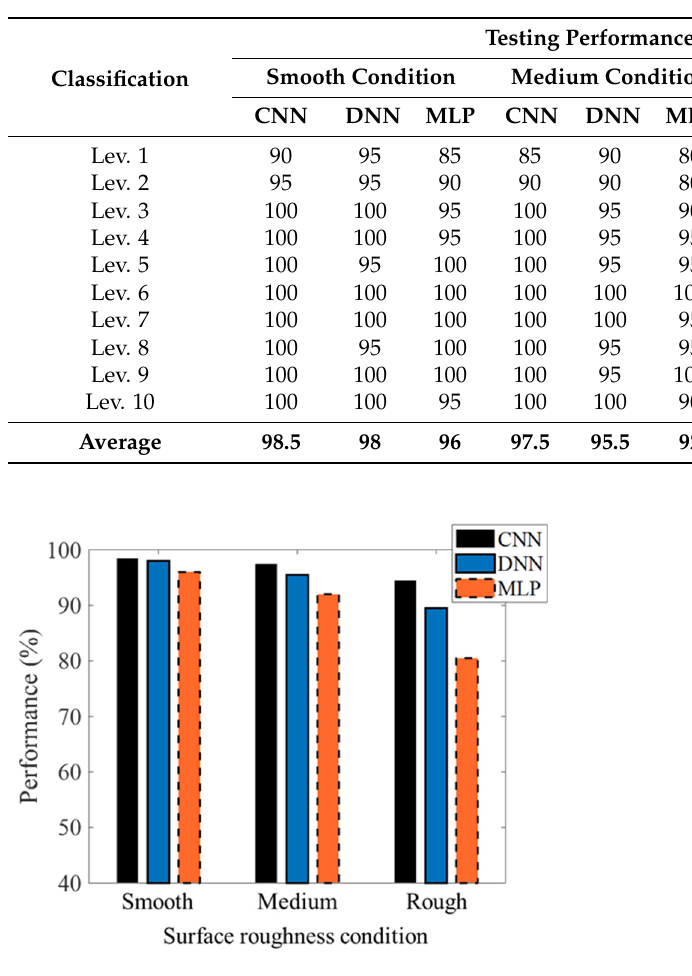
Table 6. Testing performance of the three different models for the three different surface roughness